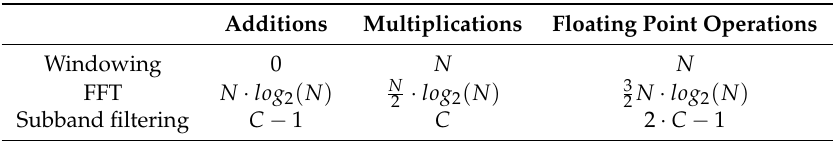
Table 2. Computational cost analysis of the audio